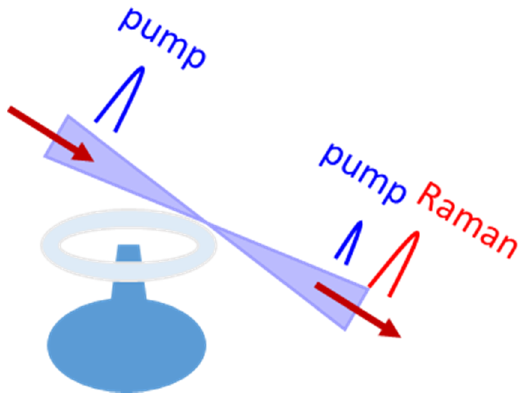
Figure 5. Schematic example of a taper-toroid coupling system.